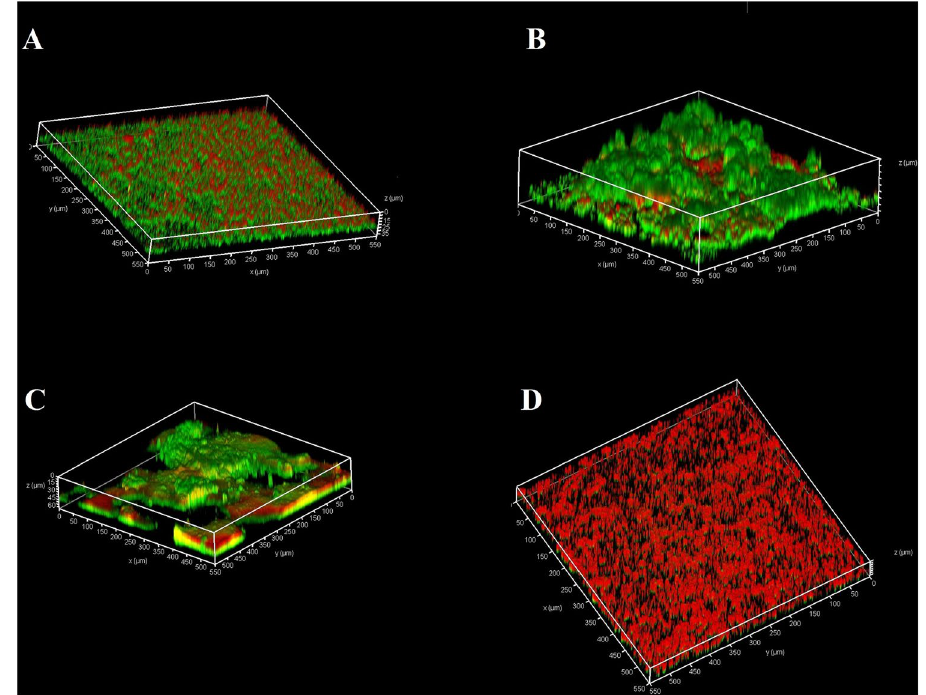
Figure 2. CLSM images of 21-day biofilm of E. faecalis that had been treated with solutions for 7 days. The control group was not treated with chemicals. ( A ), control group; ( B ), Ca(OH) 2 ; ( C ), Ca 2+ ; D, OH -